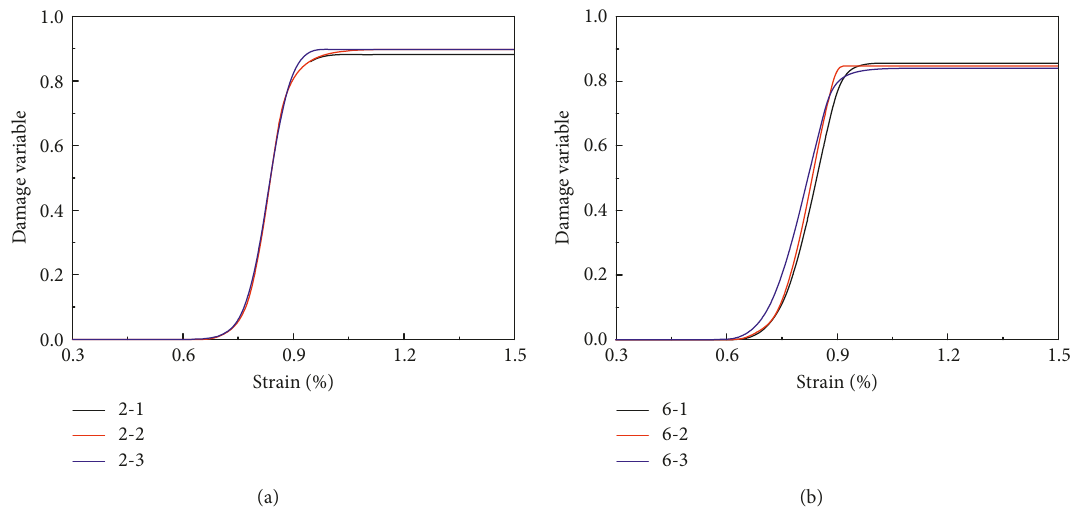
Figure 8: Relation curves between damage variable and strain: (a) HDC 2 and (b) HDC